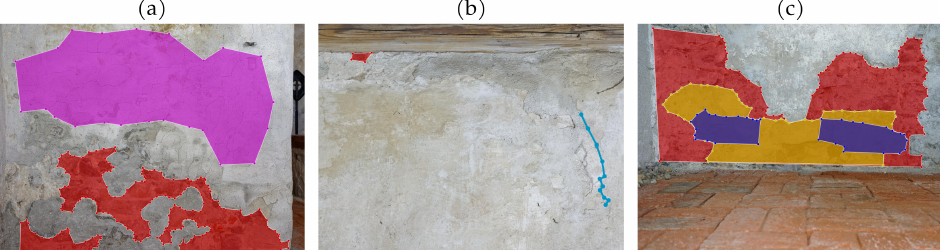
Figure 4. Examples of annotated damages: ( a ) areas of missing plaster (red) and craquele (purple), ( b ) a crack polyline (light blue) and a small missing plaster detail as a polygon (red), and ( c ) the synthetic multitemporal labels for the case study in t 1 (blue), t 2 (yellow), and t 3 (red) for a missing plaster